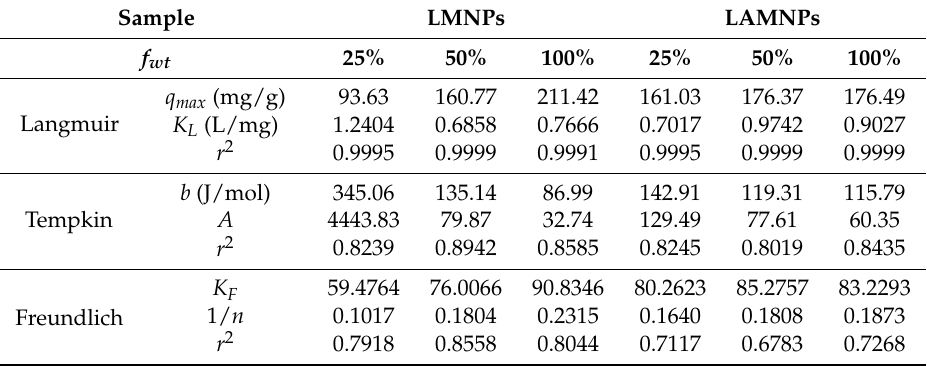
Table 3. Isotherm parameters for adsorption of MB onto LMNPs and AS-GR onto LAMNPs.